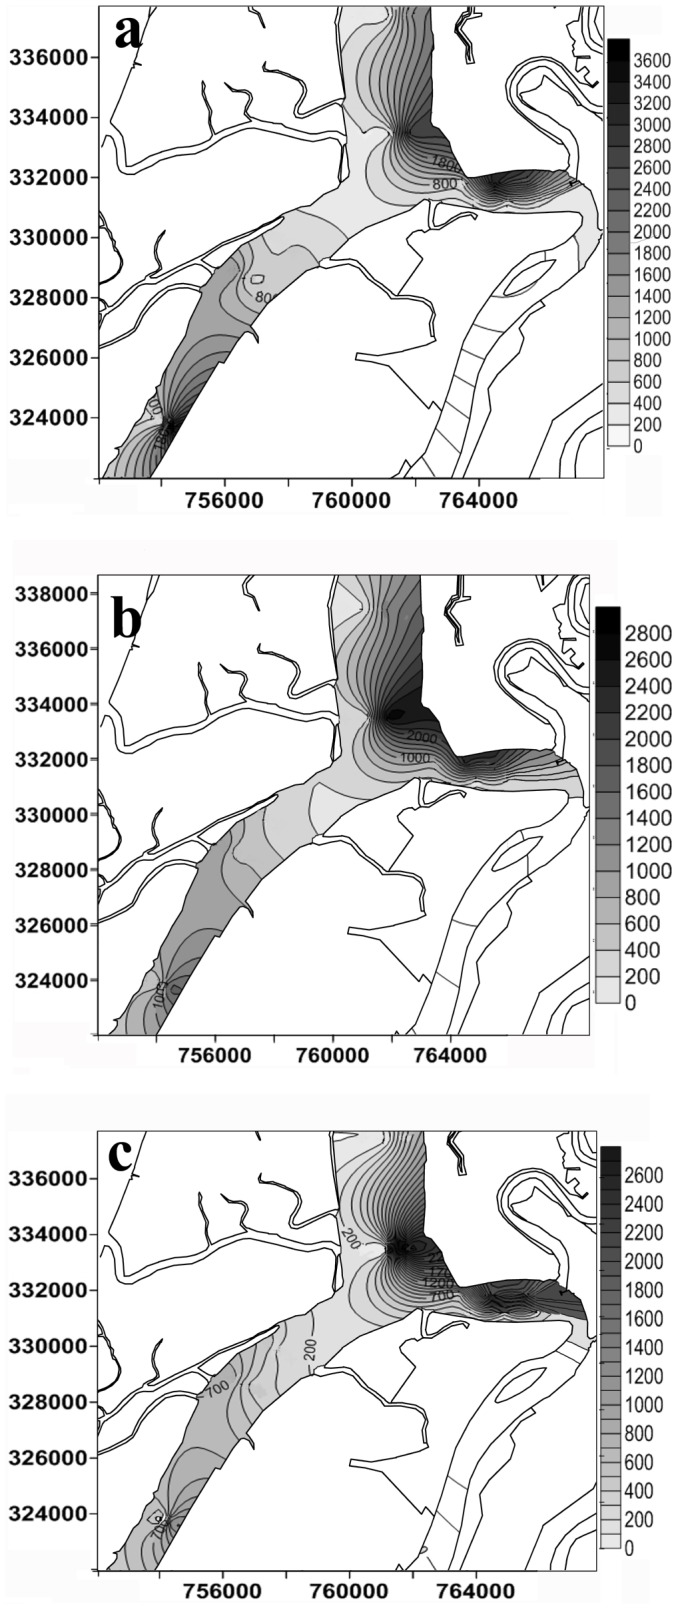
Spatial variations of PAHs compounds in surface sediment of the Klang Strait (a: Total PAHs, b: PAHs combust, c: PAHs toxic).